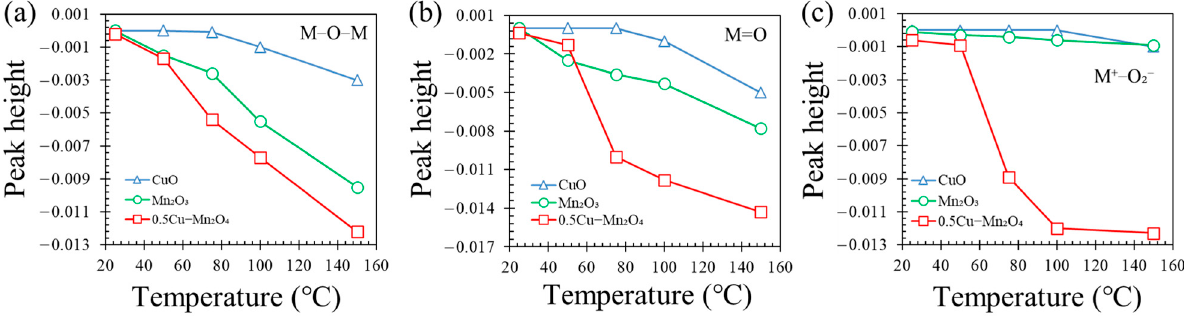
on each catalyst as functions 2